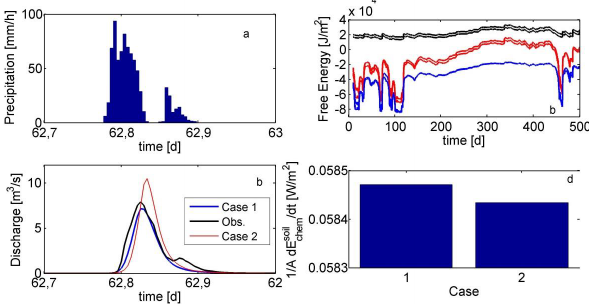
Fig. 14. Precipitation (a) and simulated catchment scale discharge (c) for case 1 (optimum macroporosity, downslope increasing macroporosity; solid blue) and case 2 (optimum, but upslope in- creasing macroporosity; solid red). The graphs are zoomed to the largest runoff event, observed on 27 June 1994. Observed discharge is in solid black. Time series of total free energy of soil water, cap- illary binding energy and potential energy for the entire period, and averaged reduction rates of free energy in soil water for both cases after Eq. (8) (d) . Note that potential energy in case 2 is during the entire period clearly larger than for case 1, which explains the dif- ference in free energy of soil